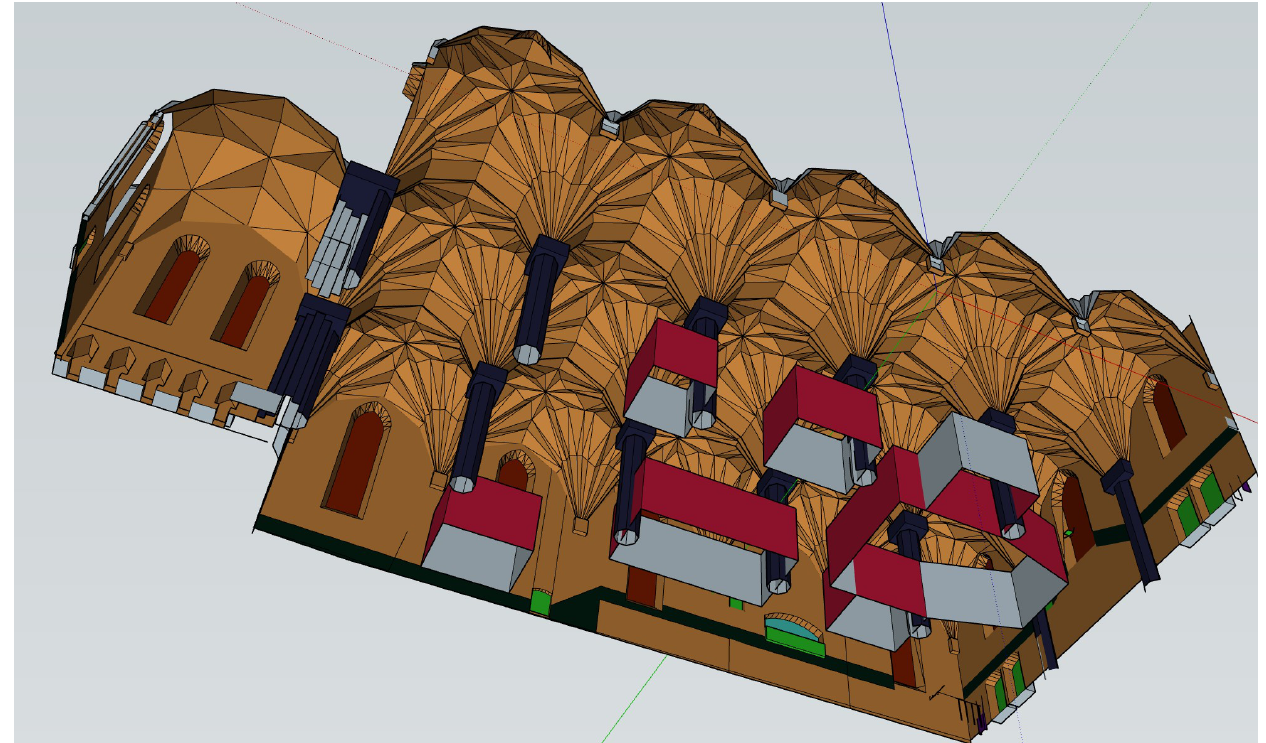
Figure 6. Simplification of vaults and chapels in the acoustic model, view from below with floor layer being hidden. The elaborate wooden walls around the altars and graves (compare to Figure 3) are rendered with boxes which are assigned a 45% transparency in ODEON. Screenshot from Google Sketch-up.